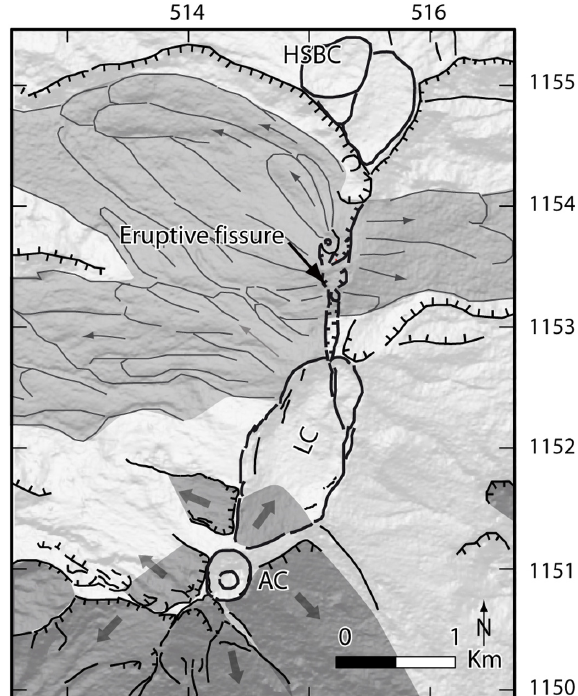
Fig. 5. Morphostructural analysis of the summit of Kanlaon vol- cano on a 10m DEM. Arrows show the principal drainage paths. The summit area shows 0 ◦ N − 30 ◦ E-oriented craters and eruptive fissures. HSBC: Hardin Sang Balo crater; LC: Lugad crater; AC: active crater. See Fig. 4 for